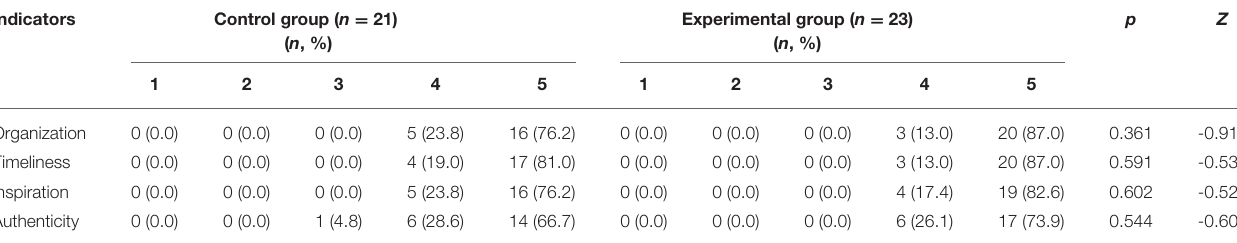
TABLE 4C | Evaluation of the teacher’s performance (simulation debriefing). Indicators Control group ( n = 21)